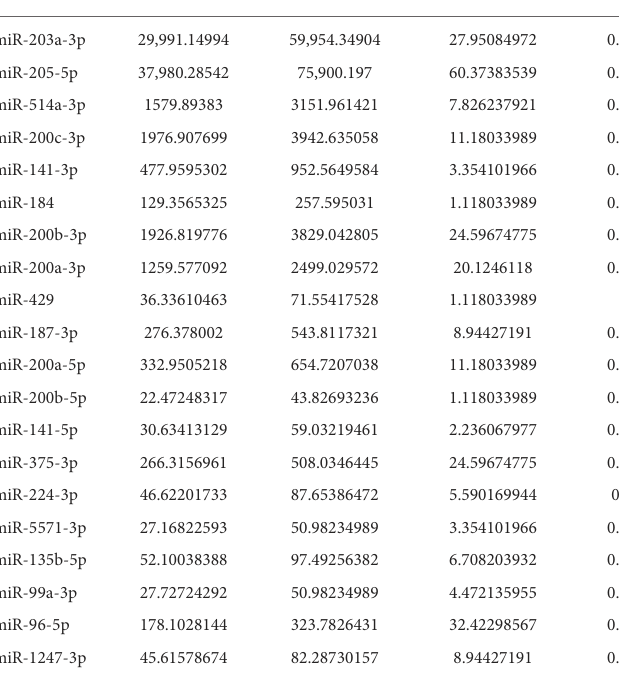
TABLE 1D Top 20 miRNAs signi fi cantly downregulated in wound of diabetic patients.